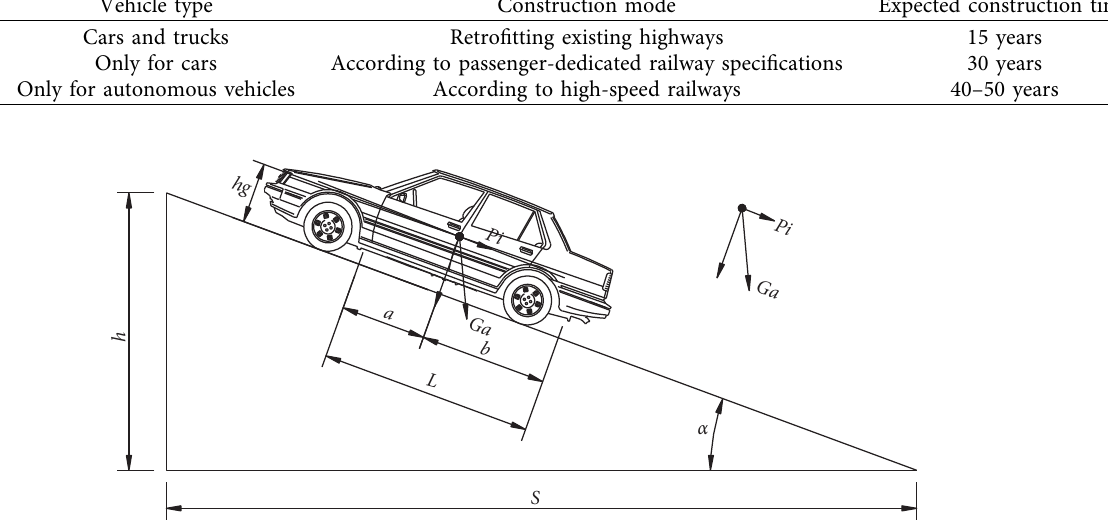
Figure 1: Force analysis while driving on a